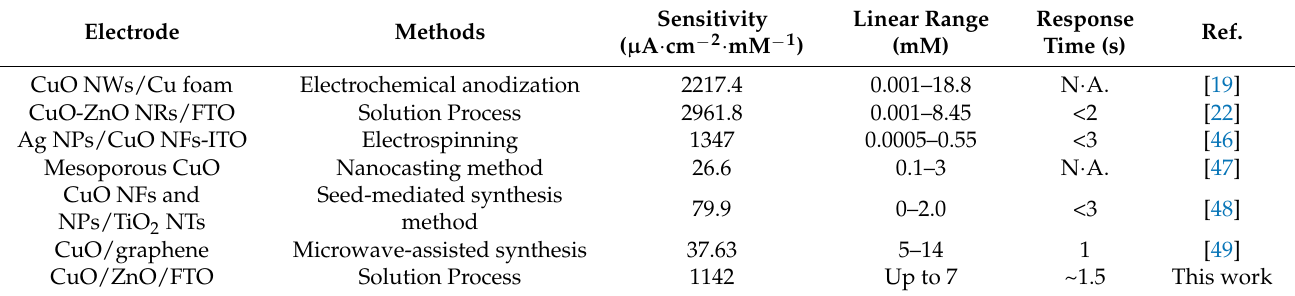
Table 1. Comparison of various non-enzymatic electrochemical sensors based on CuO electrodes.